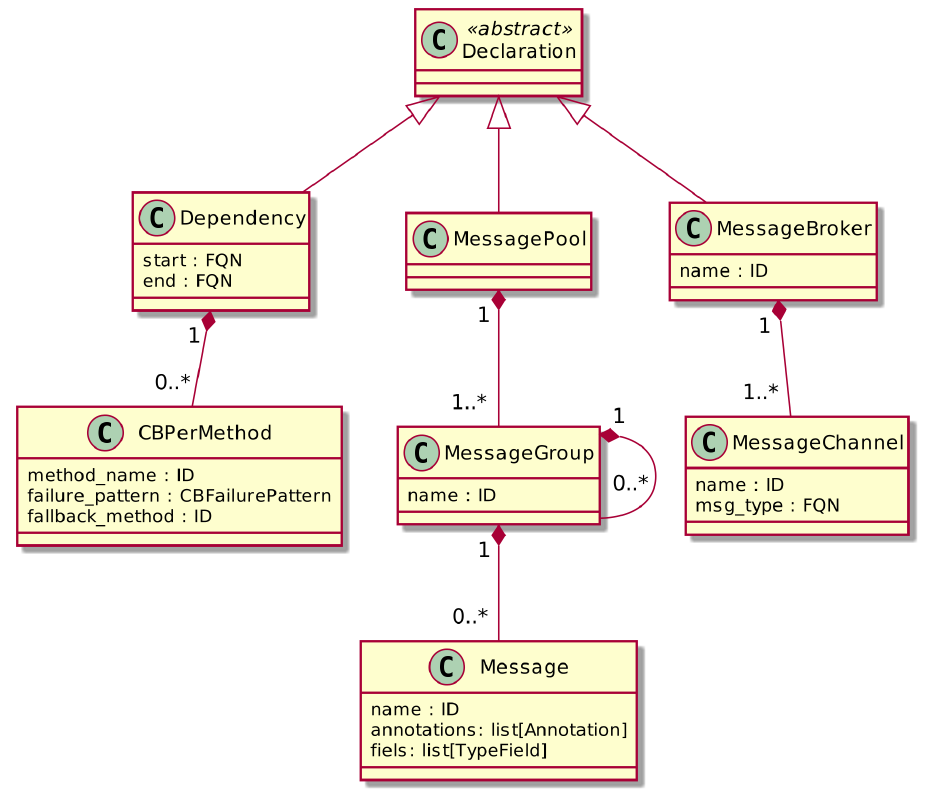
Figure 2. The simplified version of the Silvera metamodel (part